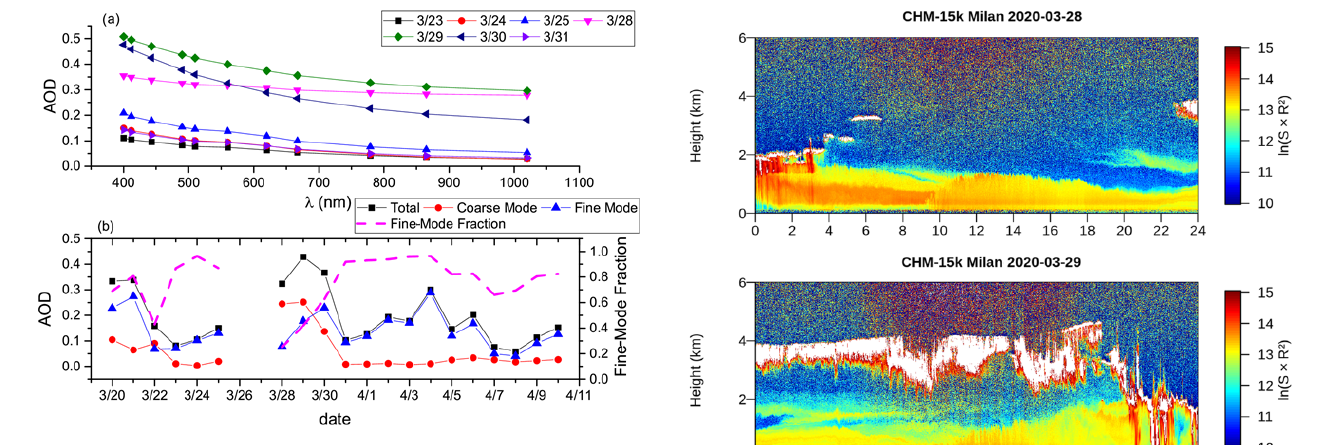
Figure 8. (a) Aerosol optical depth (AOD) at different wave- lengths and for different days in March 2020 detected at the Venice AERONET site. (b) Time series of the total-, coarse-, and fine-mode AOD as well as the fine-mode fraction observed in March–April 2020 at the Venice AERONET site. (Please note that dates are dis- played using a month/day format in this figure.)